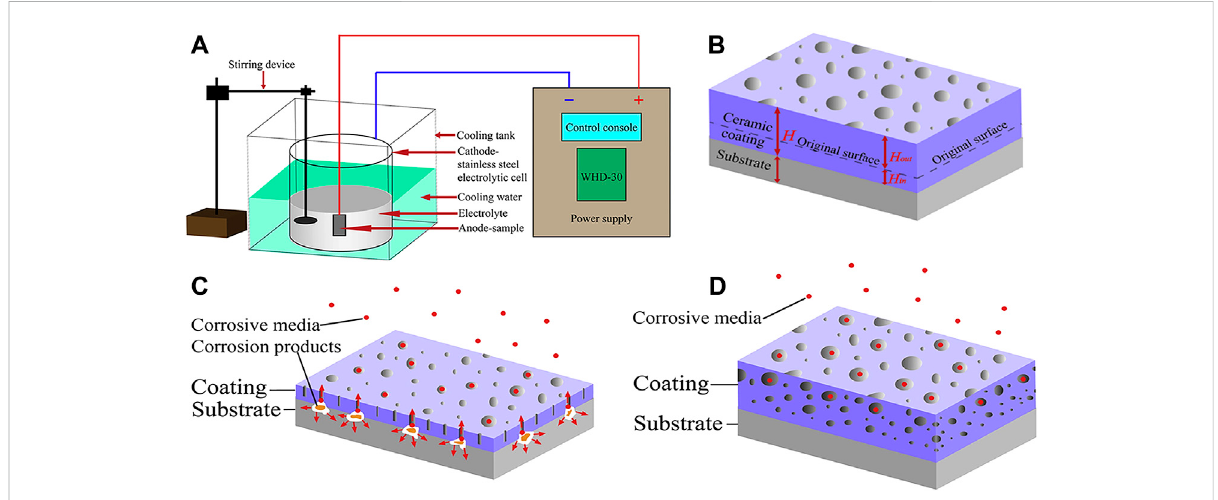
FIGURE 4 The schematic diagrams of (A) MAO device, (B) growth model;the corrosion mechanism of MAO coating: (C) thincoating with through-pores; (D) thicker coating with complex pores. Reprinted with permission from reference (Liu et al., 2020a),